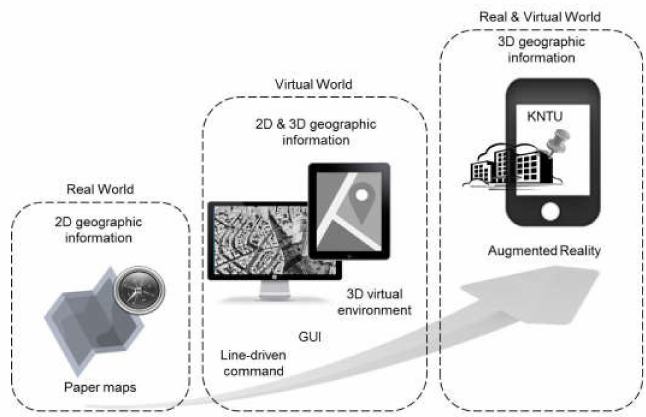
Figure 1. Evolution of GIS user